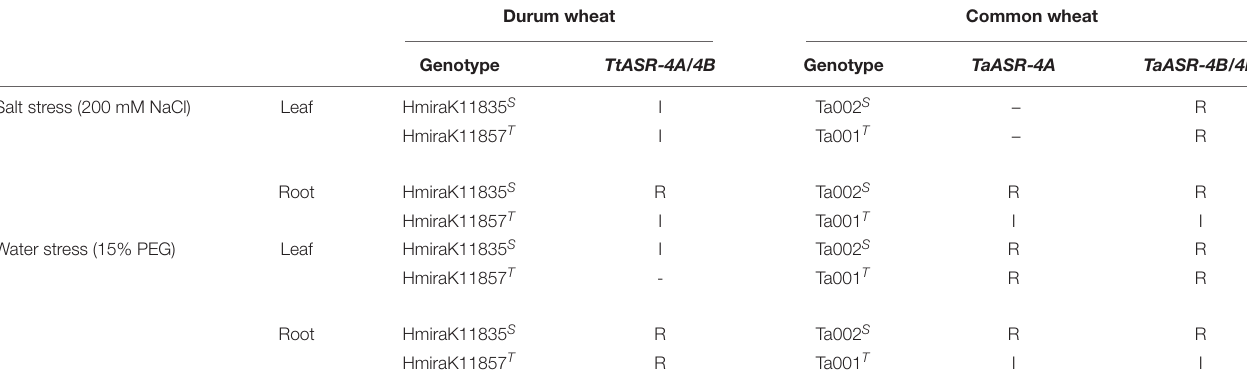
TABLE 2 | Summary of ASR genes response to high salinity and water deficit in leaves and roots of Tunisian durum and common wheat